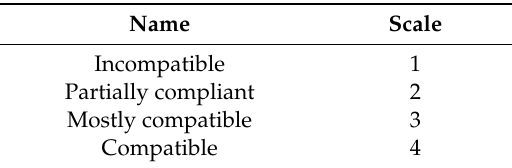
Table 3. The numerical scale of assessment of detailed criterion X 3,3 —the investment compliance with local policies.